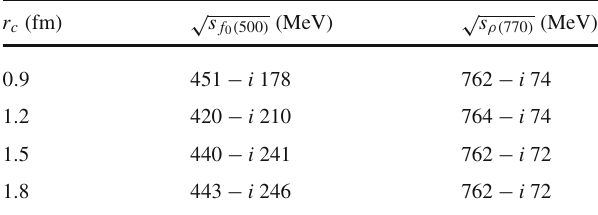
Table 8 f 0 ( 500 ) and ρ( 770 ) resonance poles obtained from the differ- ent fits including the TPE chiral tail with an increasing number of delta shells separated by (cid:14) r = 0 . 3